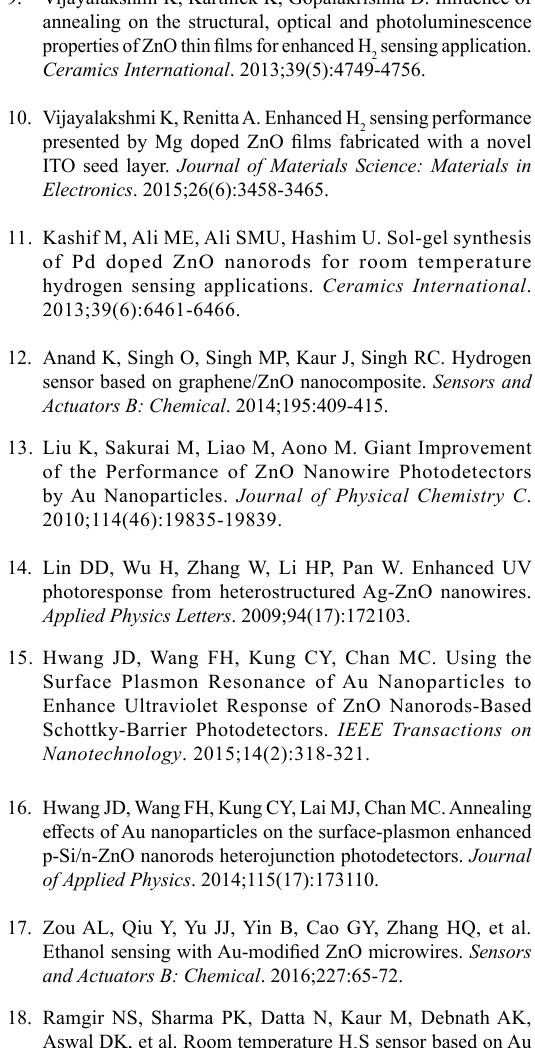
gas flow at 300 ºC 2